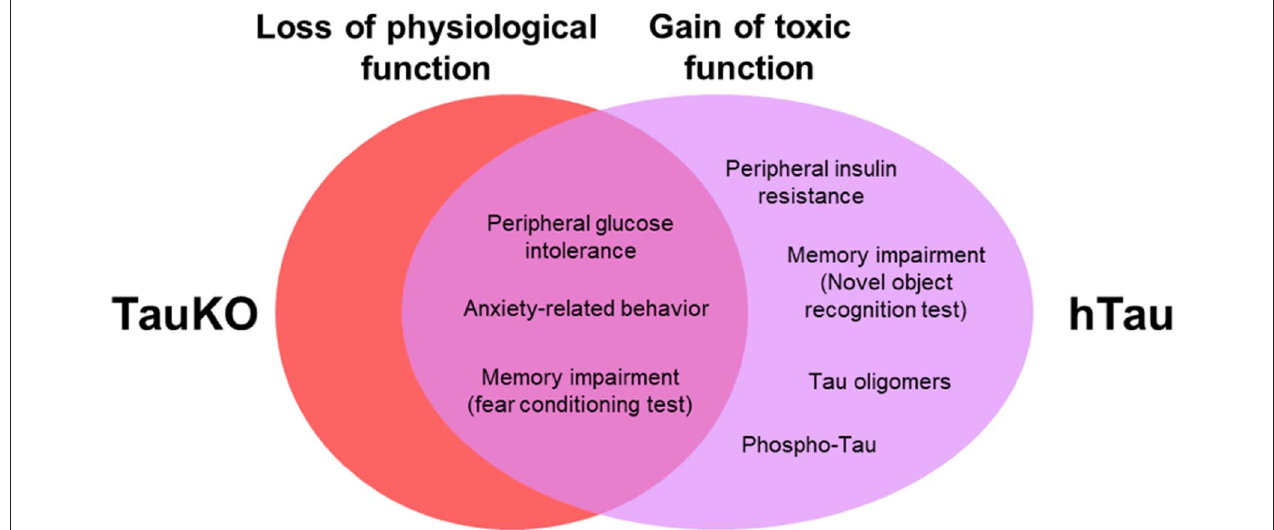
FIGURE 5 | Behavioral and metabolic alterations in TauKO and hTau mice. Here, we hypothesize that tau loss of function in the knockout, and a combined loss and gain of toxic function for tau in the hTau mice, underlie the behavioral and metabolic alterations observed in both mouse models in this